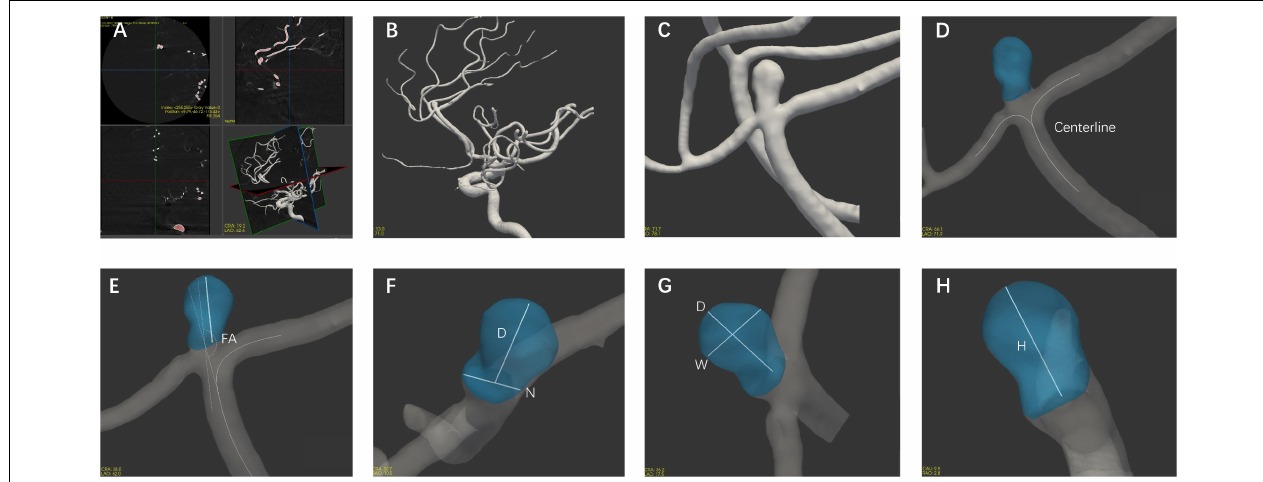
FIGURE 1 | Flow chart of the CASAM method for measuring the morphological parameters of aneurysms. (A) Import of original data; (B) 3D vessel reconstruction; (C) selection of region of interest; (D) segmentation of aneurysm using centerline method; and (E–H) measurement of morphological parameters of aneurysm and export of all parameters. D, diameter; N, neck width; W, width; H, height; FA, flow angle; PA, parent artery diameter.